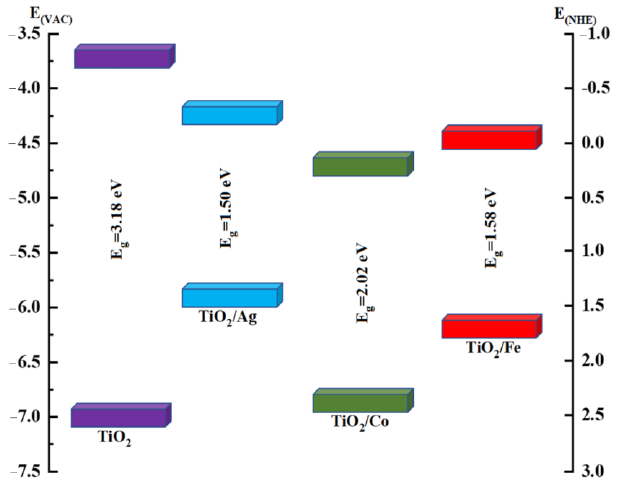
Figure 5. Band-edge comparisons of pure and doped TiO 2 anatase in electron volts. The energy scale is represented in (eV) using either the normal hydrogen-electrode potential (NHE) or the vacuum level as a reference.